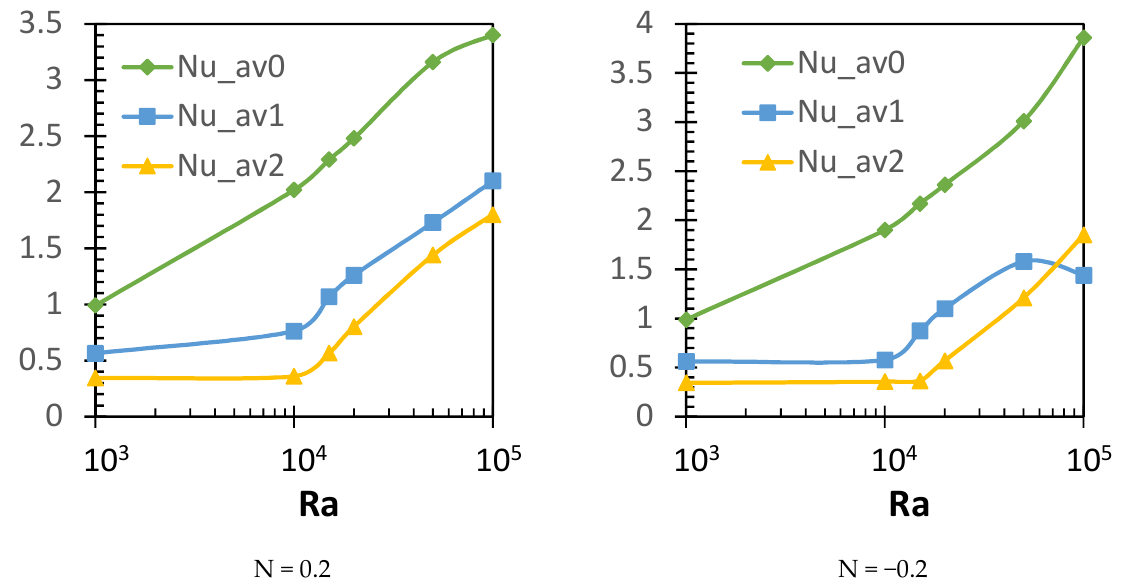
Figure 20. Effect of the Rayleigh number on the average heat transfer ratios for N = 0.2 and N = −0.2, (0): reference case, (1): H 1 = 0.25 and (2) for H 2 = 0.5.